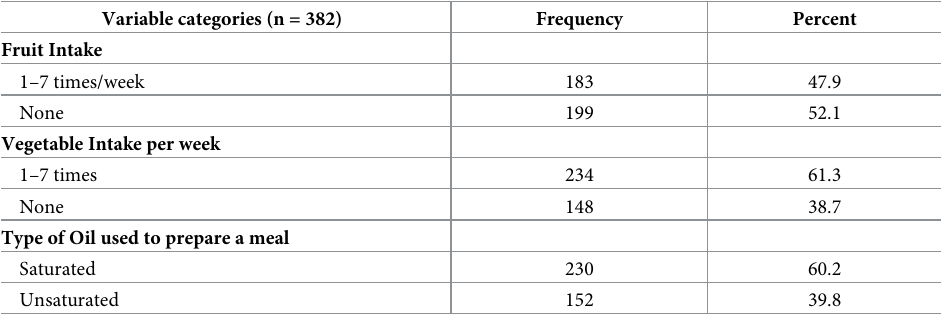
Table 4. Diet related characteristics of clients receiving HAART at NEMMRH, Southern Ethiopia, January 20-March 20,